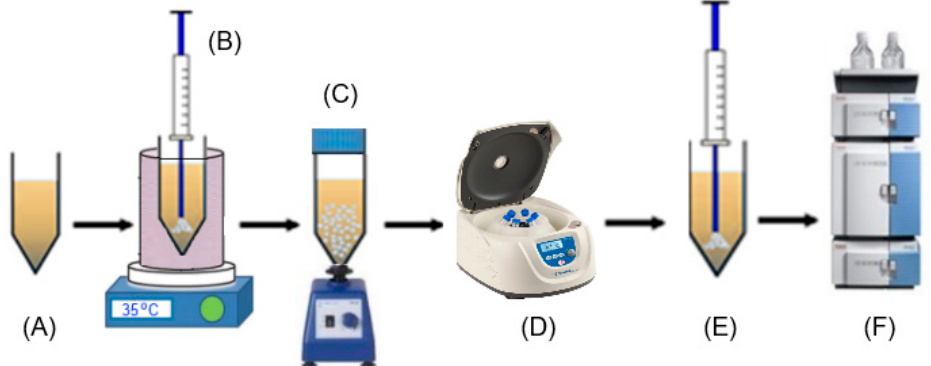
Figure 6. Scheme of the RP-DLLME-HPLC procedure. ( A ) Diluted oil sample; ( B ) injection of DES; ( C ) vortexing; ( D ) centrifugation; ( E ) retrieval of the DES phase; ( F ) HPLC measurement. First, a 1.0 g sample measured in a 15 mL amber glass centrifuge tube was diluted to